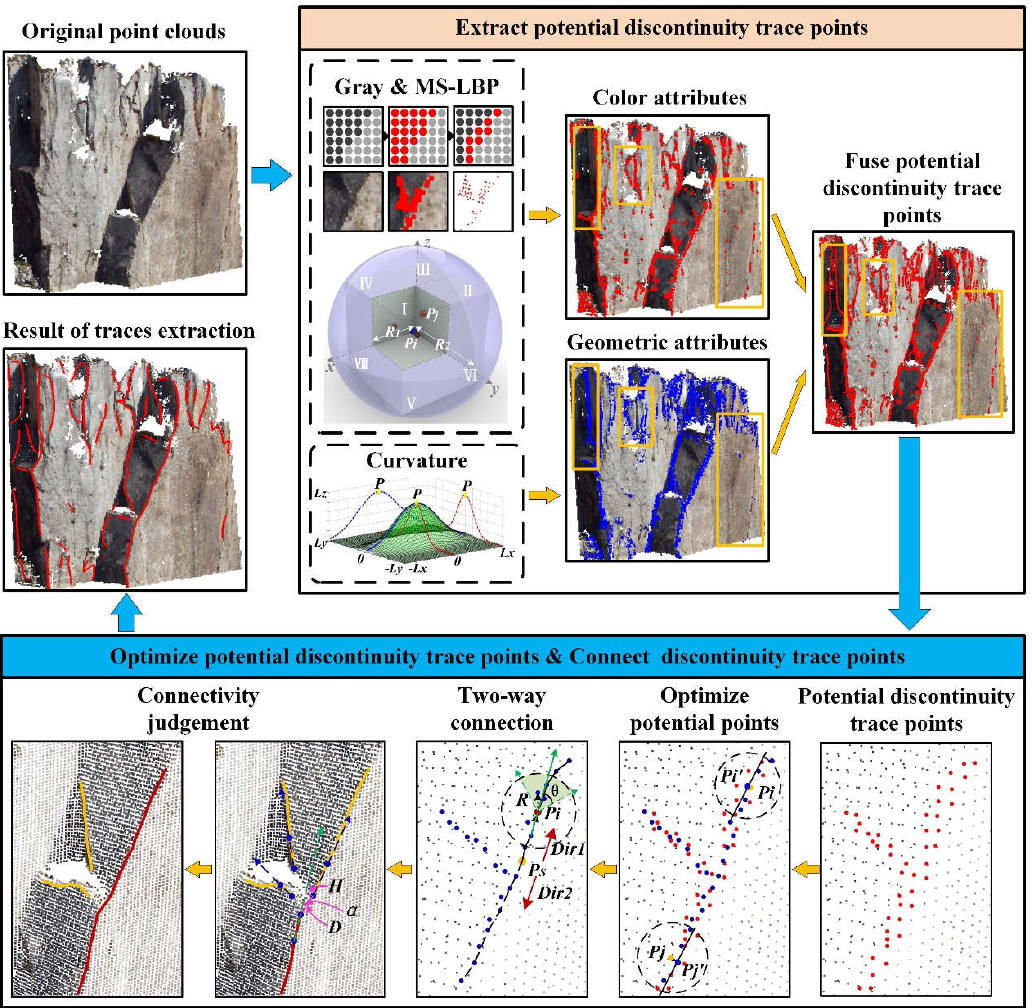
Figure 1. The framework of the process of the proposed method.